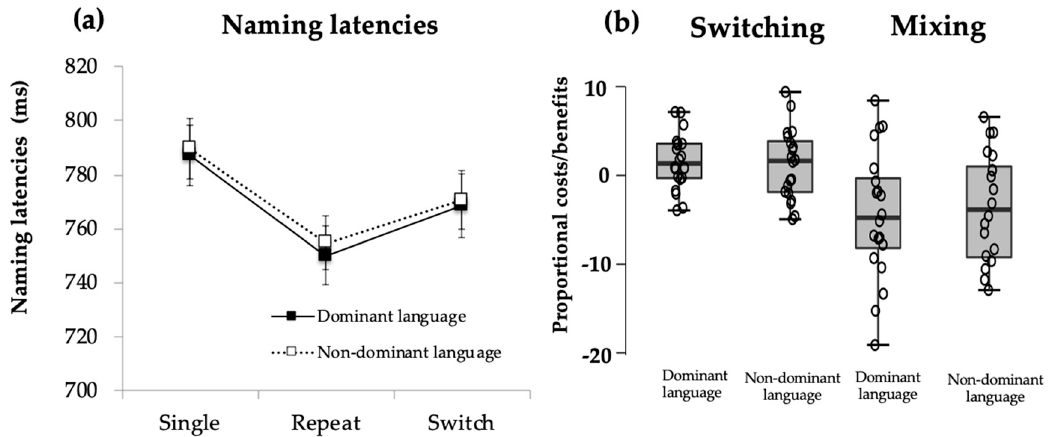
Figure 1. Performance on voluntary switching task for young, healthy Catalan-Spanish bilinguals: ( a ) Naming latencies show significant differences between switch and repeat trials (switch cost) and between repeat and single trials (mixing benefit) with no effect of language. ( b ) Distribution of proportional switching and mixing effects in bilingual participants.